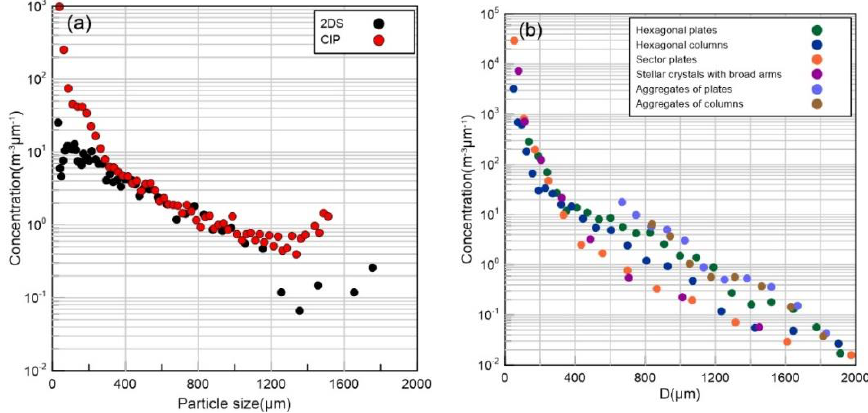
Figure 9. Particle size distribution observed by 2D-S and CIP probes ( a ) and retrieved by MMCR at 4.5 km ( b ).